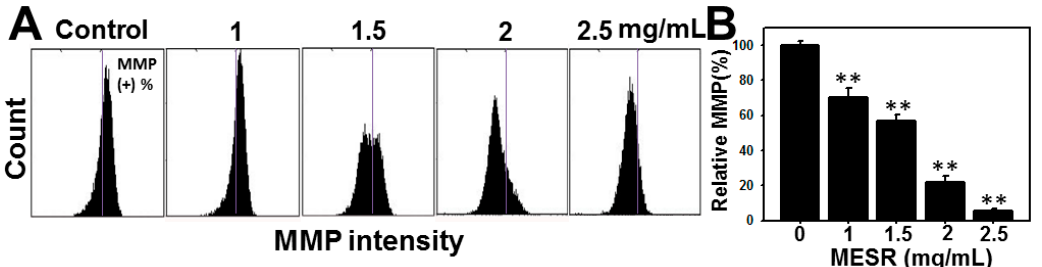
Figure 5. Changes of MMP levels of MESR-incubated Ca9-22 oral cancer cells. Cells were incubated with MESR (0–2.5 mg/mL) for 24 h for flow cytometry analysis. The vertical lines in each plot dichotomised the MMP intensity scales into 50%/50% in reference to the left and right sides of control. The right side of MMP intensity was regarded as MMP-positive (%). ( A ) Typical MMP patterns of MESR-incubated Ca9-22 cells. ( B ) Statistics of relative MMP-positive intensity (%) in Figure 5A. All the MMP intensity data were normalized to control as 100% for the relative MMP (%) calculation. Data, means ± SDs ( n = 3). ** p < 0.001 against